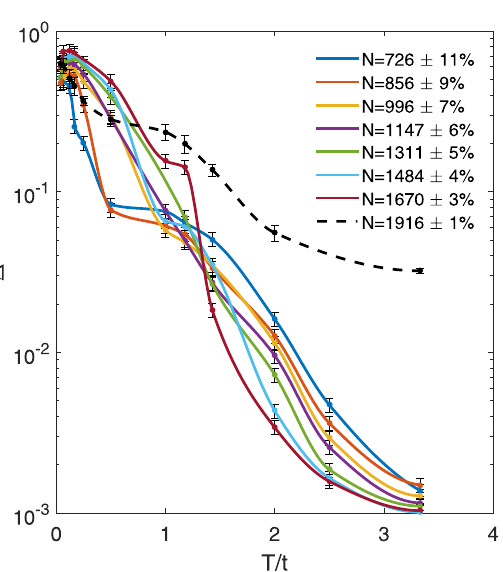
Figure 4. Δ parameter as a function of temperature in the trapped case. Solid lines: ω = . t / ; black dashed line: and ω = . t